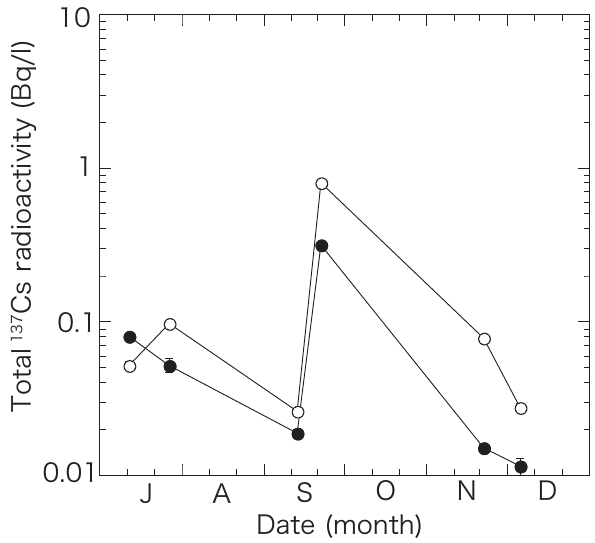
Fig. 3. Total radioactivity of 137 Cs in water samples from the Natsui River ( ◦ ) and the Same River ( • ) during July–December